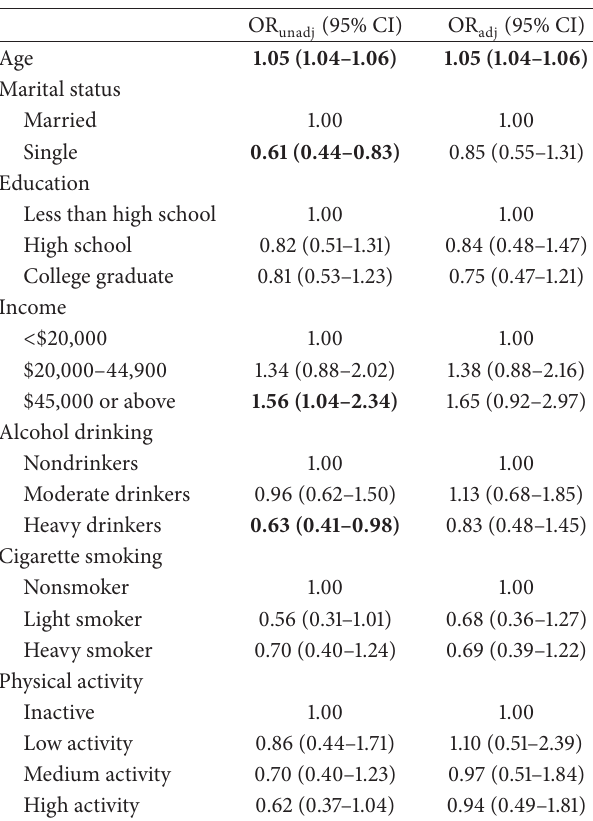
Table 3: Predictive factors for metabolic syndrome among African American women using weighted estimates: from the NHANES 1999– 2006 ∗